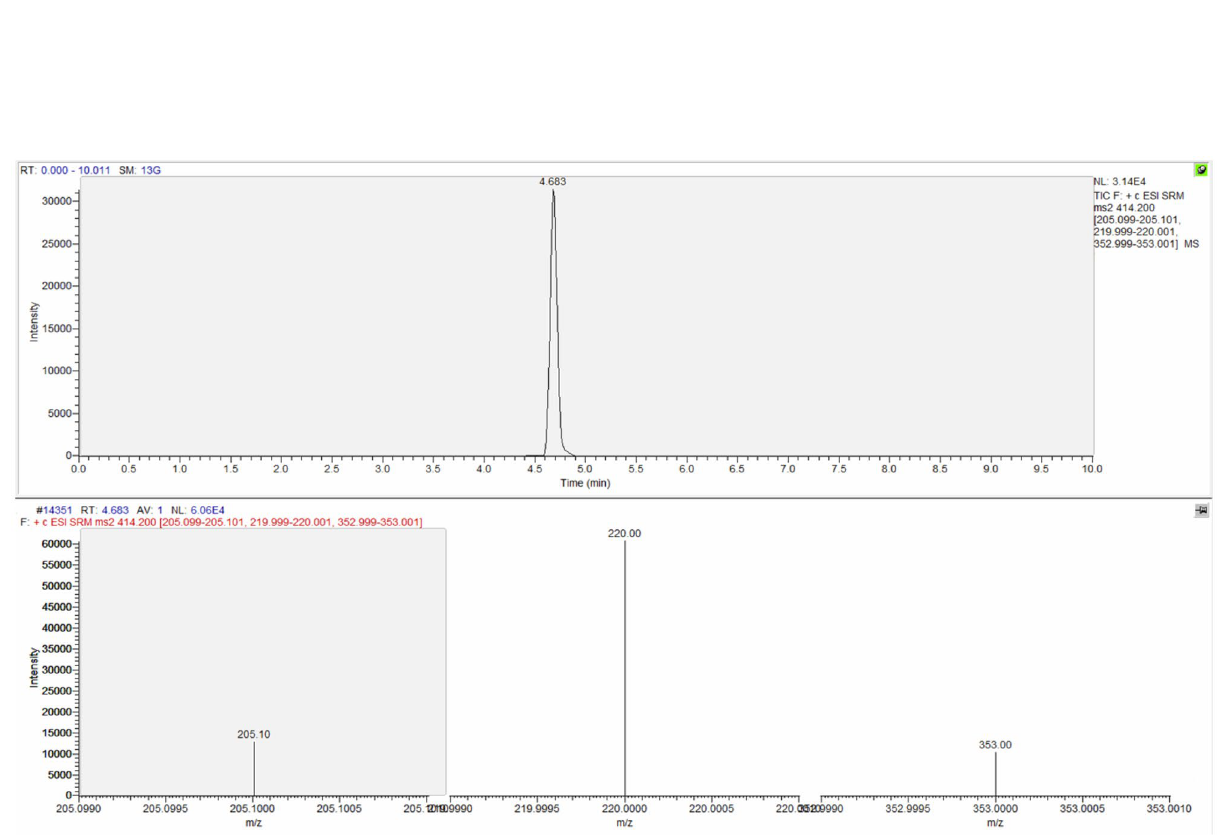
Figure 7. Chromatographic spectrum (upper portion) and mass spectral ion ratio (bottom raw) of noscapine detected in